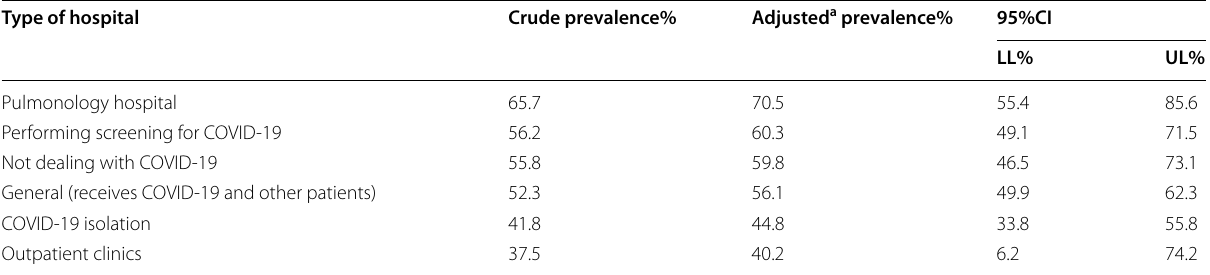
Table 3 Prevalence of anti‑S positive results among 416 unvaccinated HCWs according to the type of hospital, Egypt, Jan‑June 2021